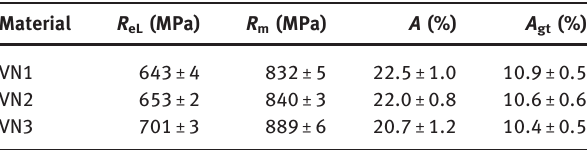
Table 3: The results of the tensile tests on the samples. Material